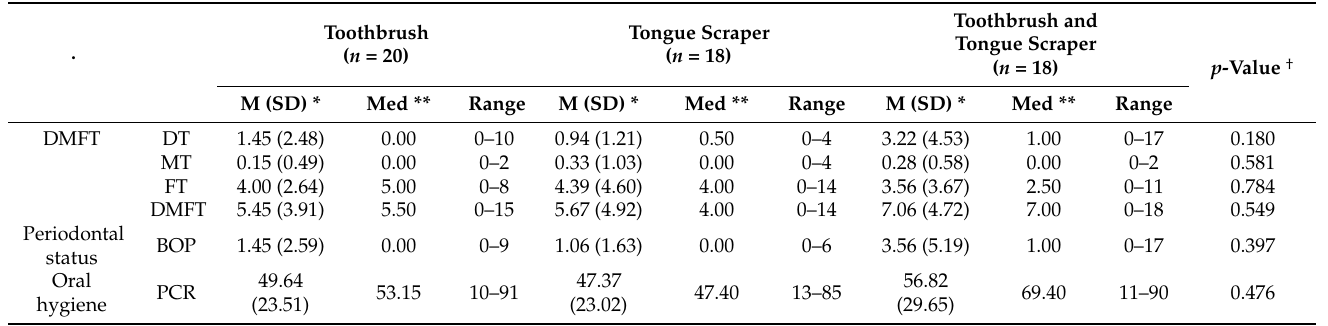
Table 1. Oral health status of the subjects (DMFT, BOP, PCR).